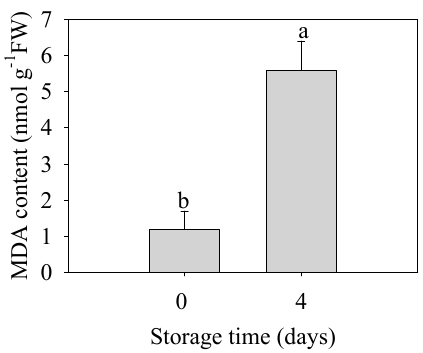
Figure 5. Changes in malondialdehyde (MDA) content in peel of banana fruit stored for 0 and 4 d at 6 °C. The data were presented as means ± standard error ( n = 3). The means with different letters were significantly different ( p < 0.05).